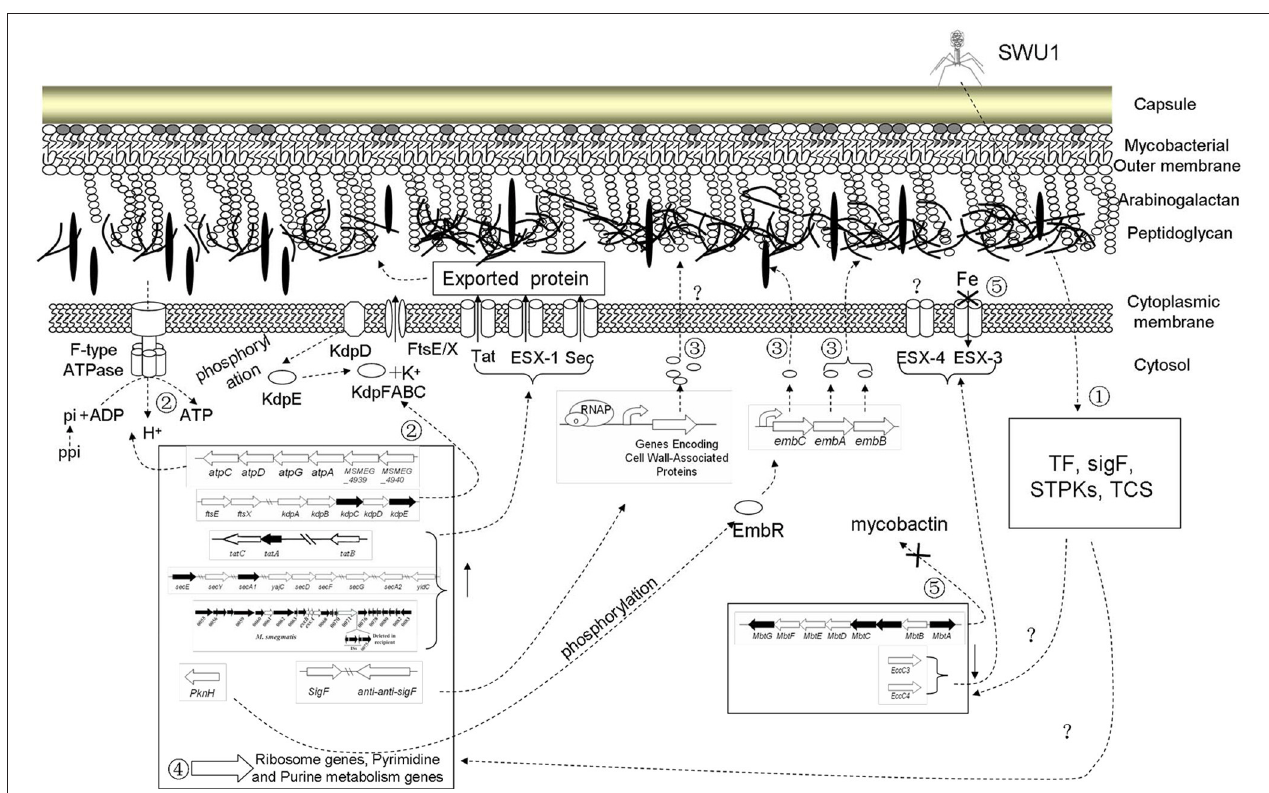
FIGURE 5 | Putative working model of M. smegmatis mc 2 155 response to phage SWU1 infection. Numbers stand for host response to SWU1 infection, which is described in summary. Hollow-out wide arrows stand for those regulated genes. Dotted lines stand for the process of regulatory network. Forks represent that the process is